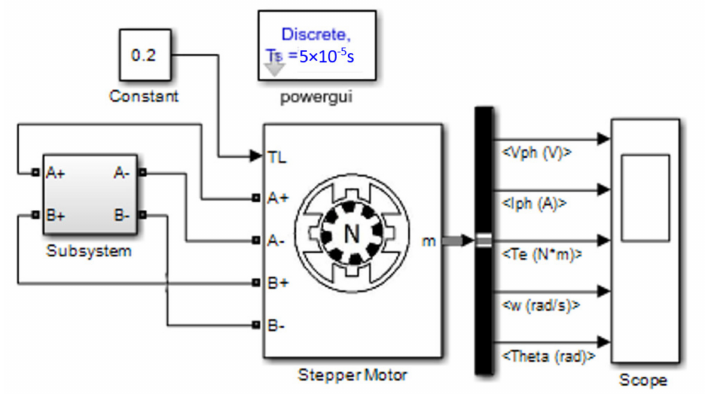
Figure 6. The stepper motor model existing the Simulink libraries of Matlab.